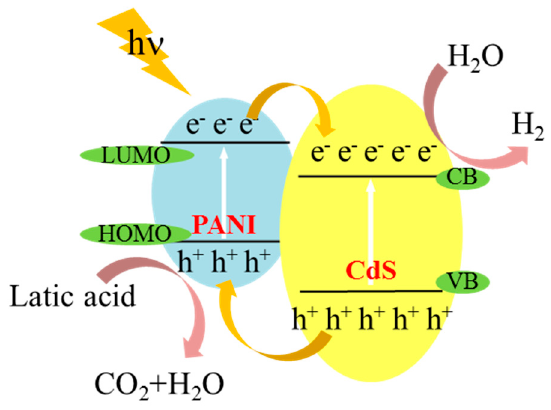
Figure 14. CdS NRs-PANI-SiO 2 hydrogel photo-catalytic hydrogen production mechanism under visible light.